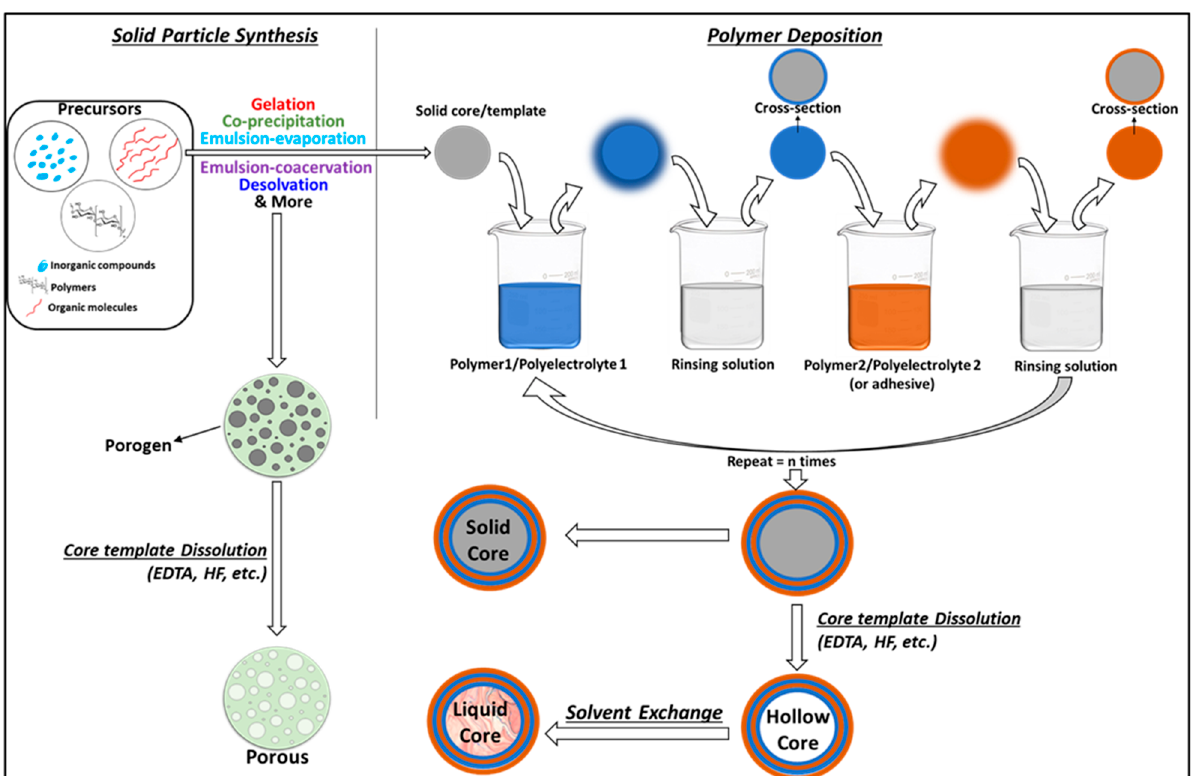
Figure 3. Schematic diagram of the solid templating approach. Preparation of hollow core capsules is straightforward by solid templating. Typically, natural polymers are deposited over a sacrificial template core to create single, double, or multilayer shells solid core microcapsules. After the deposition of the shell layer/s, the template is dissolved to give a hollow core. Many types of materials have been used as sacrificial template cores, amongst which silica and calcium carbonate [51] nano- or microparticles are the most common. The core template dissolution is carried out by immersing the capsules in a chelating solvent, such as 8% hydrofluoric acid [54] and ethylenediaminetetraacetic acid (EDTA) [55]. During this process, the solvent molecules diffuse into the capsules to dissolve the solid core. It is significant to note that the core template must be completely dissolved. To ensure that, the core removal step is repeated multiple times. However, it has been shown that the core chelating solvents are not thoroughly removed during the capsule purification step, which may pose toxicity-related issues for biological applications. Yitayew et al. gave a proof-of-concept, using endotoxin- free cell lines as sacrificial template cores to mitigate these issues. They used live E. coli DH5 cells as a sacrificial template for synthesizing hollow core chitosan–alginate multiwalled capsules [56]. The microcapsules were dispersed in lysis buffer (0.1% Triton X-100, 2 mM EDTA in 10 mM Tris-pH8) overnight and washed with acetic acid buffer to remove the template cells. It is also worth noting that the core-removal step can cause shell